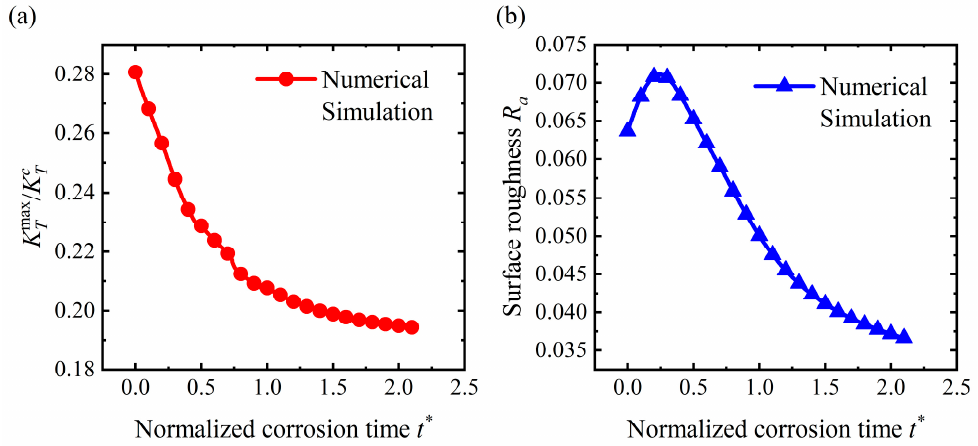
Figure 17. Evolution of ( a ) maximal stress concentration factor and ( b ) surface roughness during corrosion when A ∗ = 0.1 and σ A = 10 MPa.